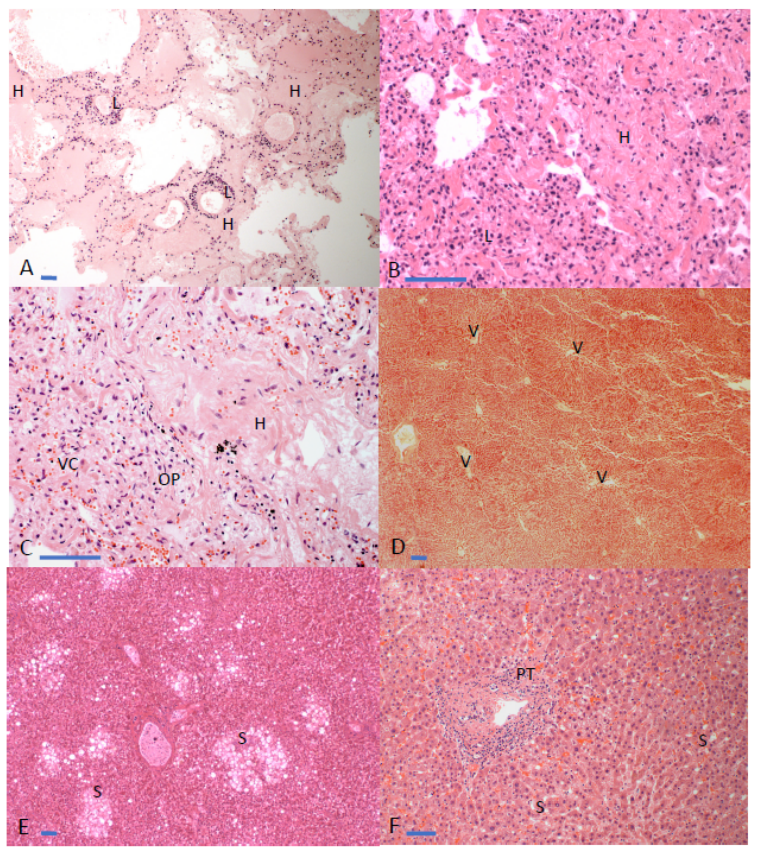
Figure 2. Examples of pulmonary and hepatic pathology from COVID-19 post-mortem cases de- scribed in Table 1. All images are of hematoxylin and eosin (H&E)-stained formalin-fixed, paraffin- embedded tissue sections. ( A ) Lung (10× objective) showing acute respiratory distress syndrome (ARDS)/ diffuse alveolar damage (DAD), with abundant hyaline material (H), forming hyaline membranes within alveoli and/ or completely filling them. Moderate numbers of lymphocytes (L) are seen. ( B ) Higher magnification (40× objective) image of lung from a different autopsy case showing similar features, such as hyaline material (H), but with more admixture of macrophage/ histiocytic cells where lymphocytes (L) are marked. ( C ) Lung (40× objective) showing hyaline material, but also an area of early organizing pneumonia (OP), as well as desquamated pneumocytes and/ or macrophages with viral cytopathic change (VC). ( D ) Liver (10× objective) showing passive venous congestion with distended sinusoids, giving an overall lobular pattern, and dilated central veins (V). ( E ) Liver (10× objective) with marked steatosis (S) or “fatty change”. ( F ) Liver (20× objective) with more subtle steatosis (S) and some portal tract (PT) expansion by fibrous tissue, as is seen in the early stages of progression of steatosis to cirrhosis.